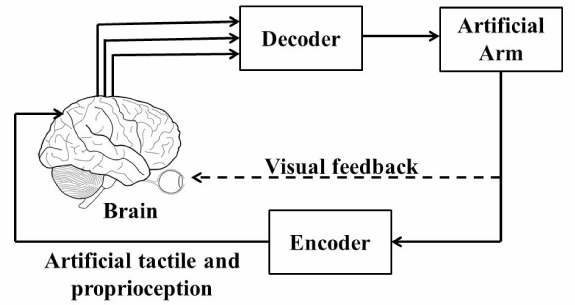
Figure 1. A closed-loop brain-machine interface